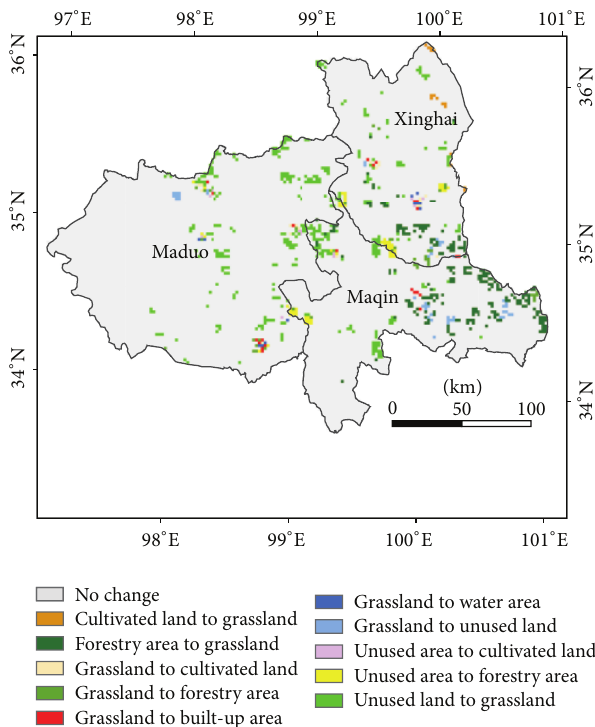
Figure 3: The spatial pattern of land surface change in the next 50 years. Only large proportion of land surface change is showed in this